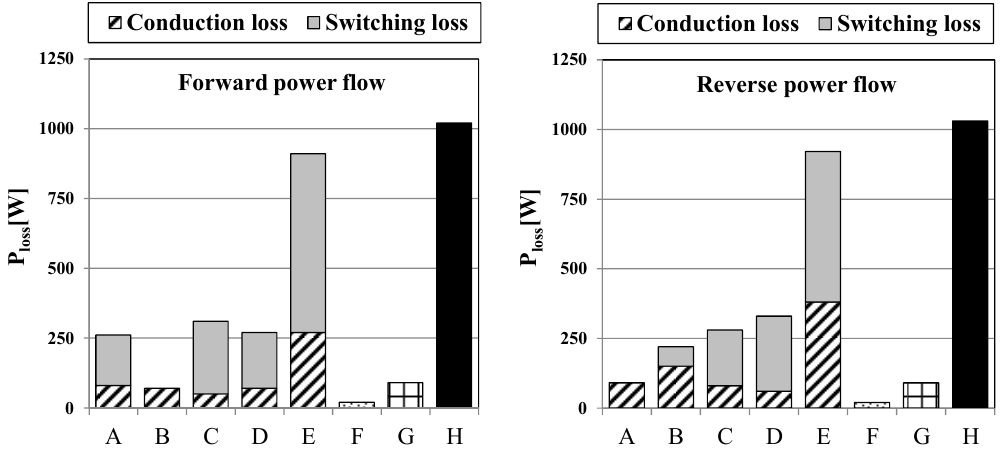
Figure 14. Loss analysis result for major element.